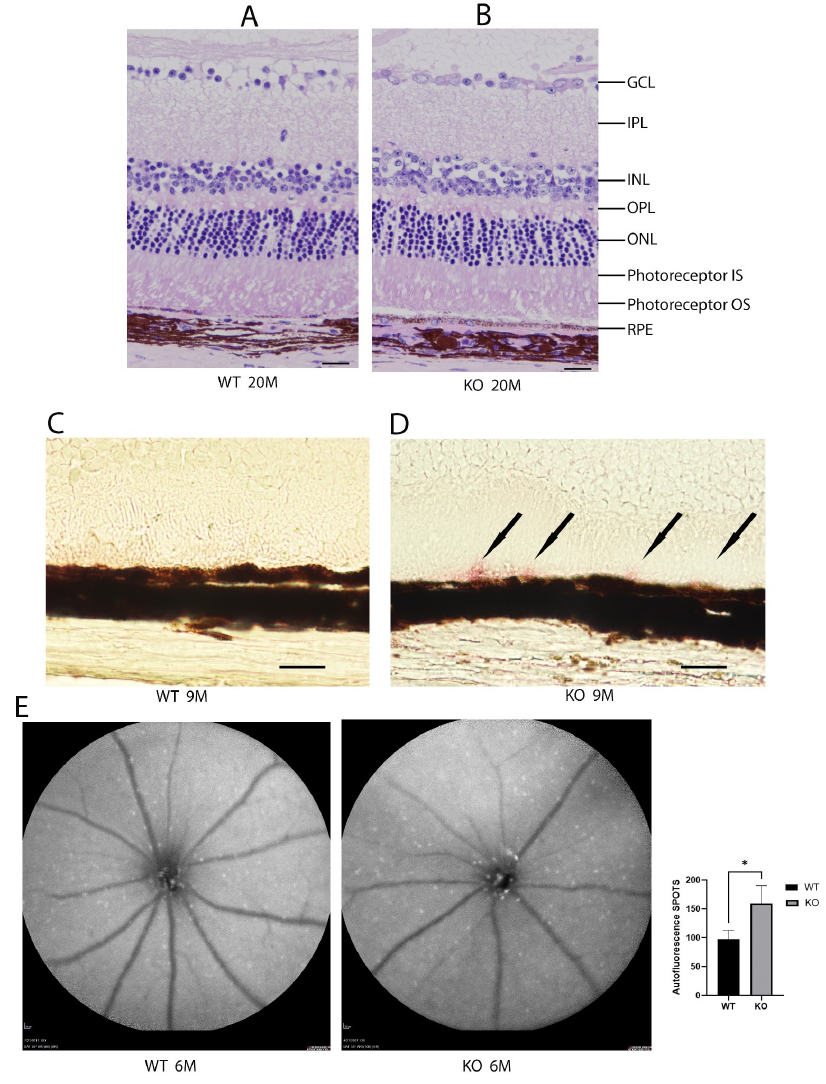
Figure 3. Histological and autofluorescence images of WT and KO mice. Hematoxylin and eosin staining of the retinas from 20-month-old mice ( A ). Wild-type and ( B ). KO mice. Representative Oil Red O staining images of 9-month-old mice ( C ). Wild-type and ( D ). KO mice. Oil Red O staining in the KO mice is indicated by black arrows. ( E ). Autofluorescence images of 6-month-old wild-type and KO mice and graphical representation of autofluorescence (n = 7 WT, 10 KO). Scale bar: 20 µm. * p < 0.05 unpaired two-tailed t -test.